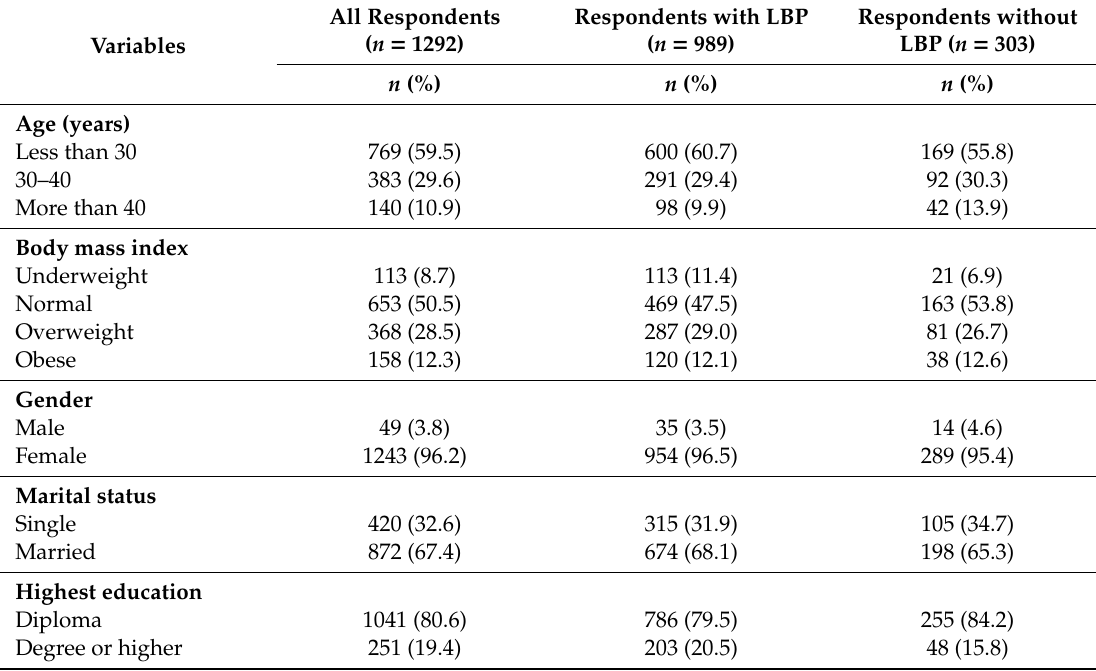
Table 2. Sociodemographic characteristics of the